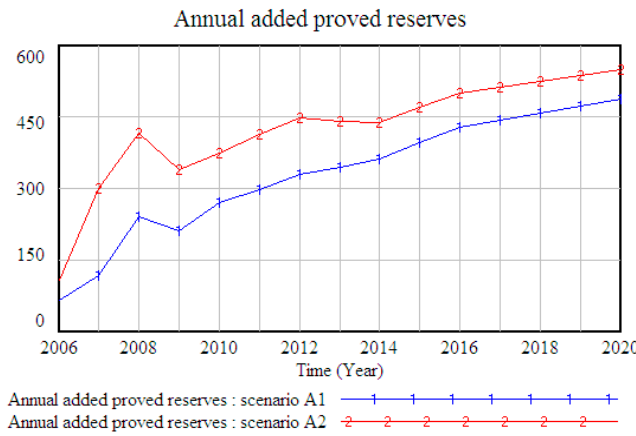
Figure 3. Annual investment (ten thousand Yuan).